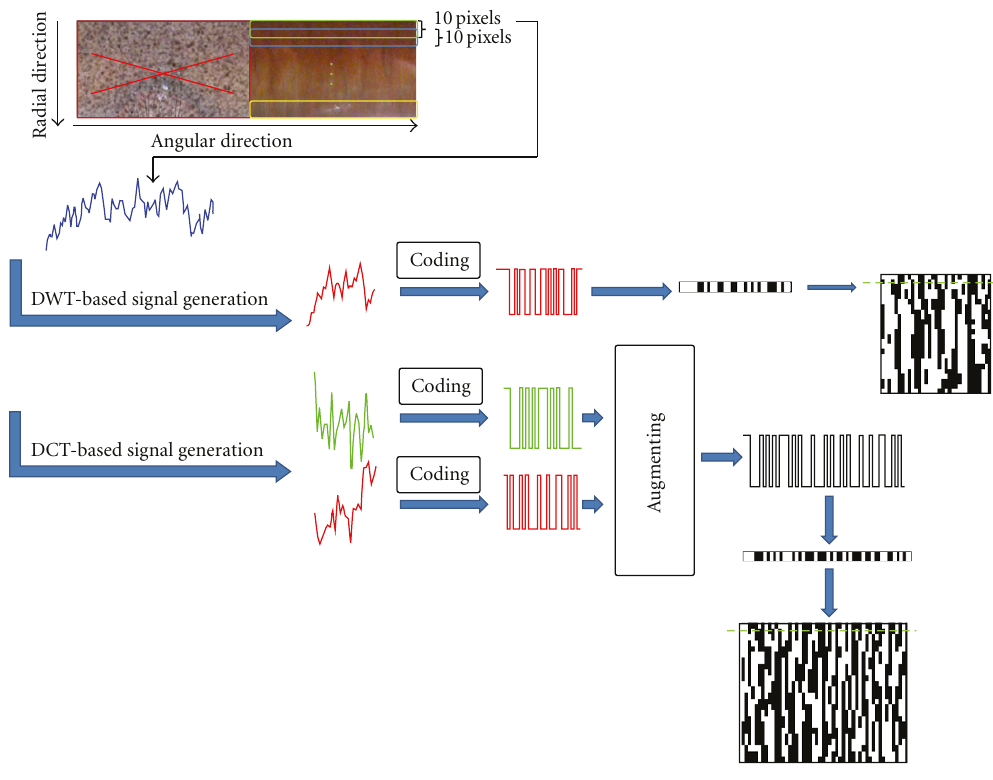
Figure 4: An overview of the proposed method for extracting local texture variations. The colored rectangles separate the region of interest into 24 tracks each 10 pixels in height. The local feature extraction is performed on each track. For visualization purposes, the height of each track is